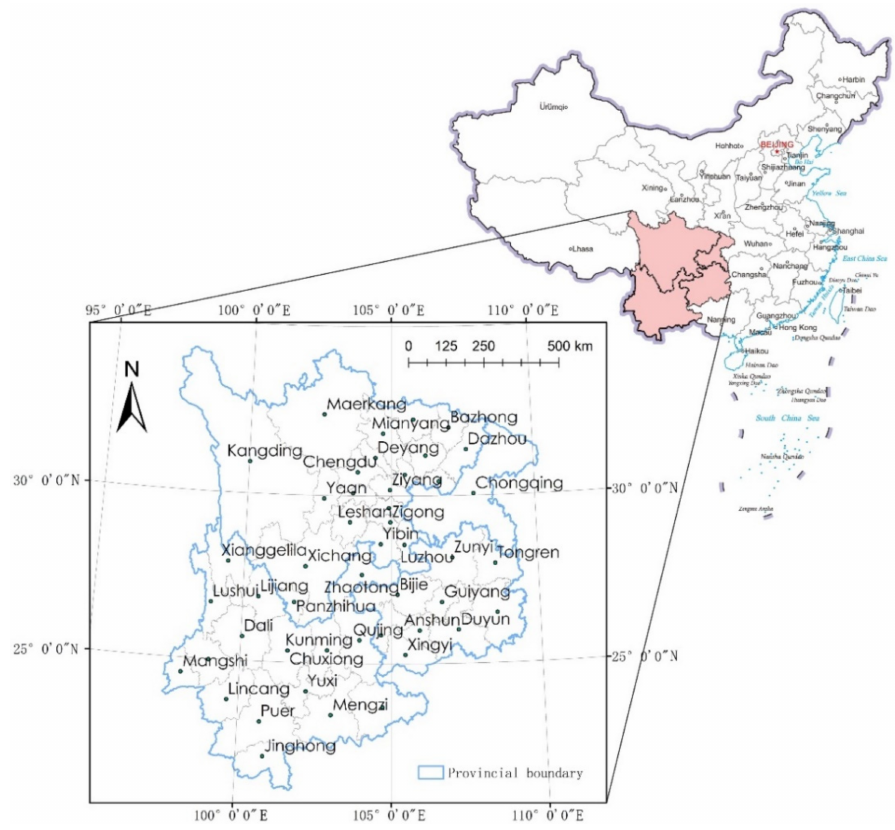
Figure 1. Research